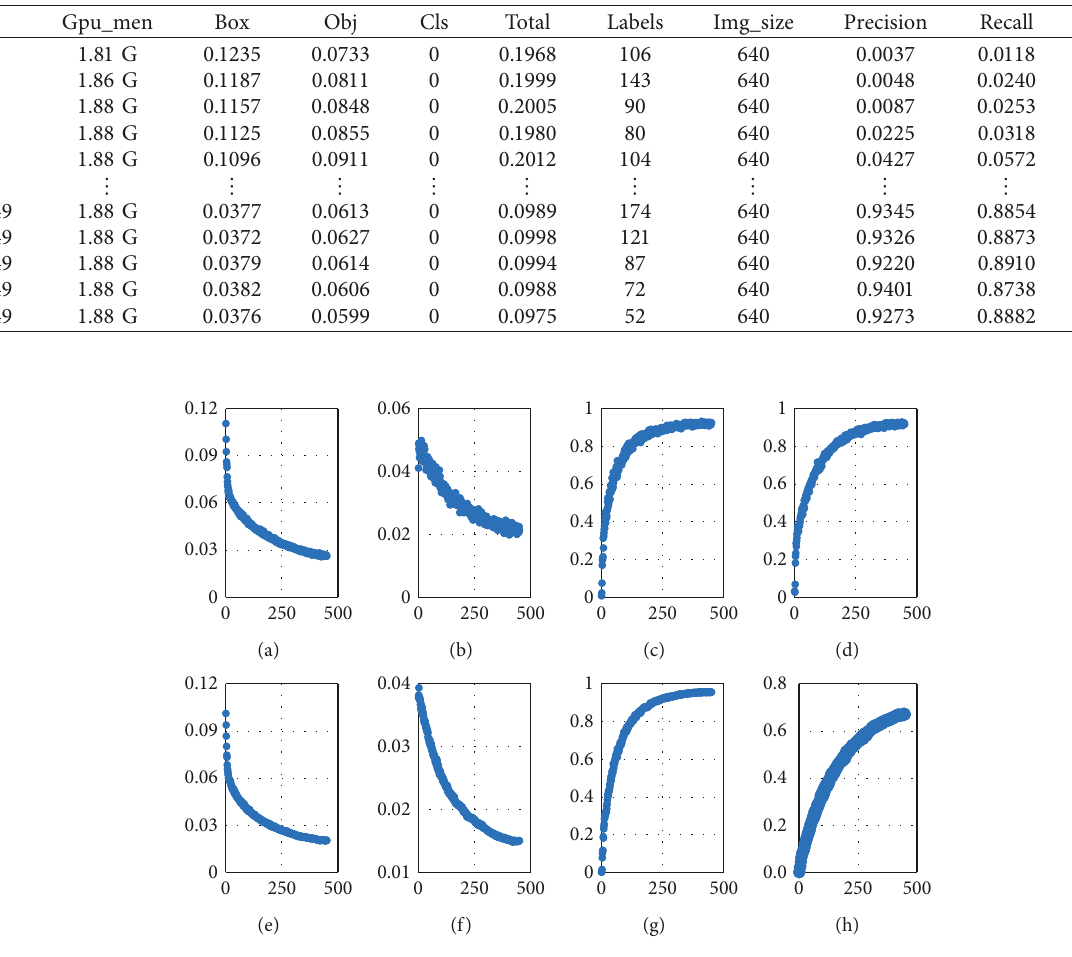
Table 6: YOLO v5 training results.